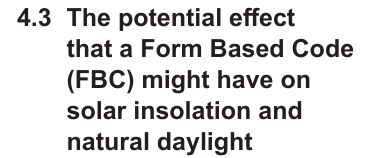
Table 6: Solar insolation and shading characteristics for building configurations A, B and C